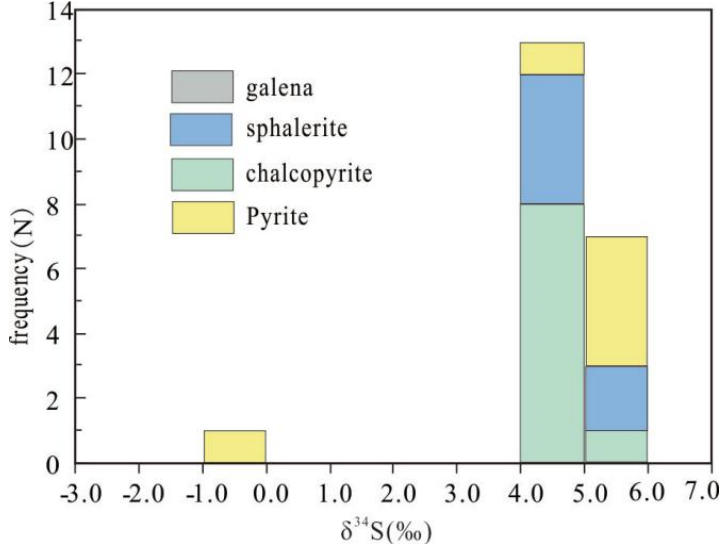
Figure 7. The histogram of S isotopes.